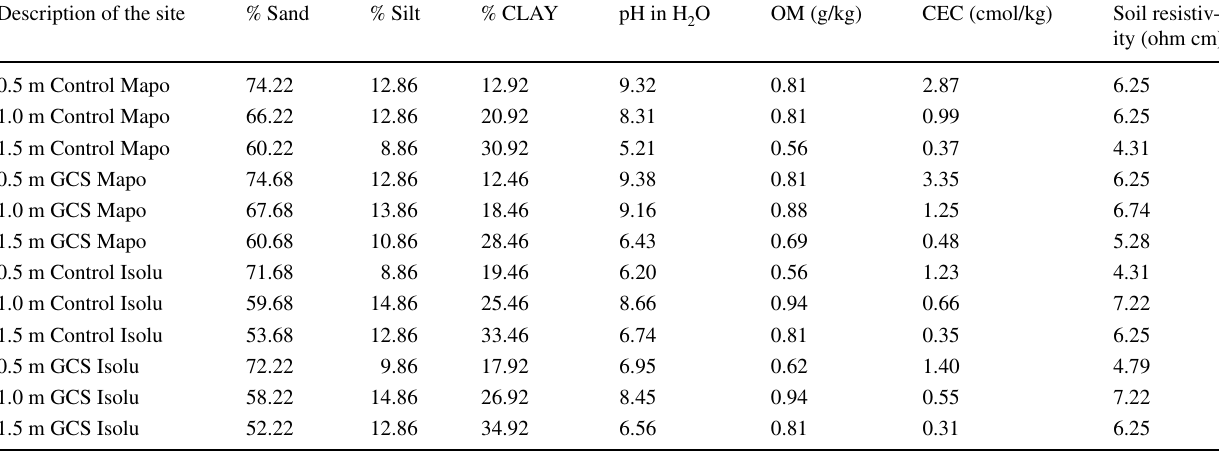
Table 1 Results of physico-chemical properties of analysed soil samples Description of the site